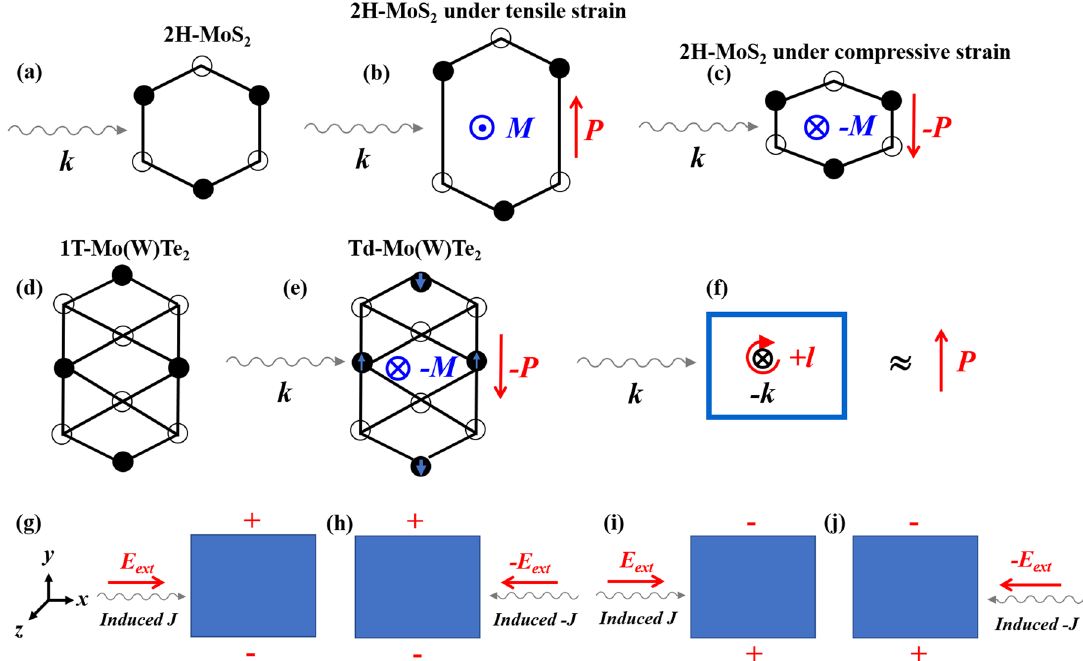
Fig. 4 Current-induced M , circular dichroism Hall effect (CDHE), and non-linear Hall effect (NLHE). a – c Monolayer of 2H-MoS 2 : ( a ); no strain, ( b ); uni-directional uniform tensile strain along the vertical direction on the page plane, and ( c ); uni-directional uniform compressive strain along the vertical direction on the page plane. d , e show monolayer 1T-Mo(W)Te 2 and T d -Mo(W)Te 2 , respectively. Closed black circles, dark- blue arrows, open black circles, wiggly arrows, red arrows, and blue symbols represent cations, cation distortions, anions, uniform electric currents, polarizations, and induced magnetizations, respectively. Thus, ( b ), ( c ), and ( e ) represent the current-induced magnetization in polar conductors. This current-induced magnetization is directly related to the presence of non-linear Hall effects in polar conductors without any external magnetic fi eld. f depicts the SOS relationship for CDHE with the electric current fl ow with k , circular-light illumination with − k and + l , and P representing the induced Hall voltage. g – j Four possible con fi gurations of Hall-type voltages induced by electric currents in external electric fi